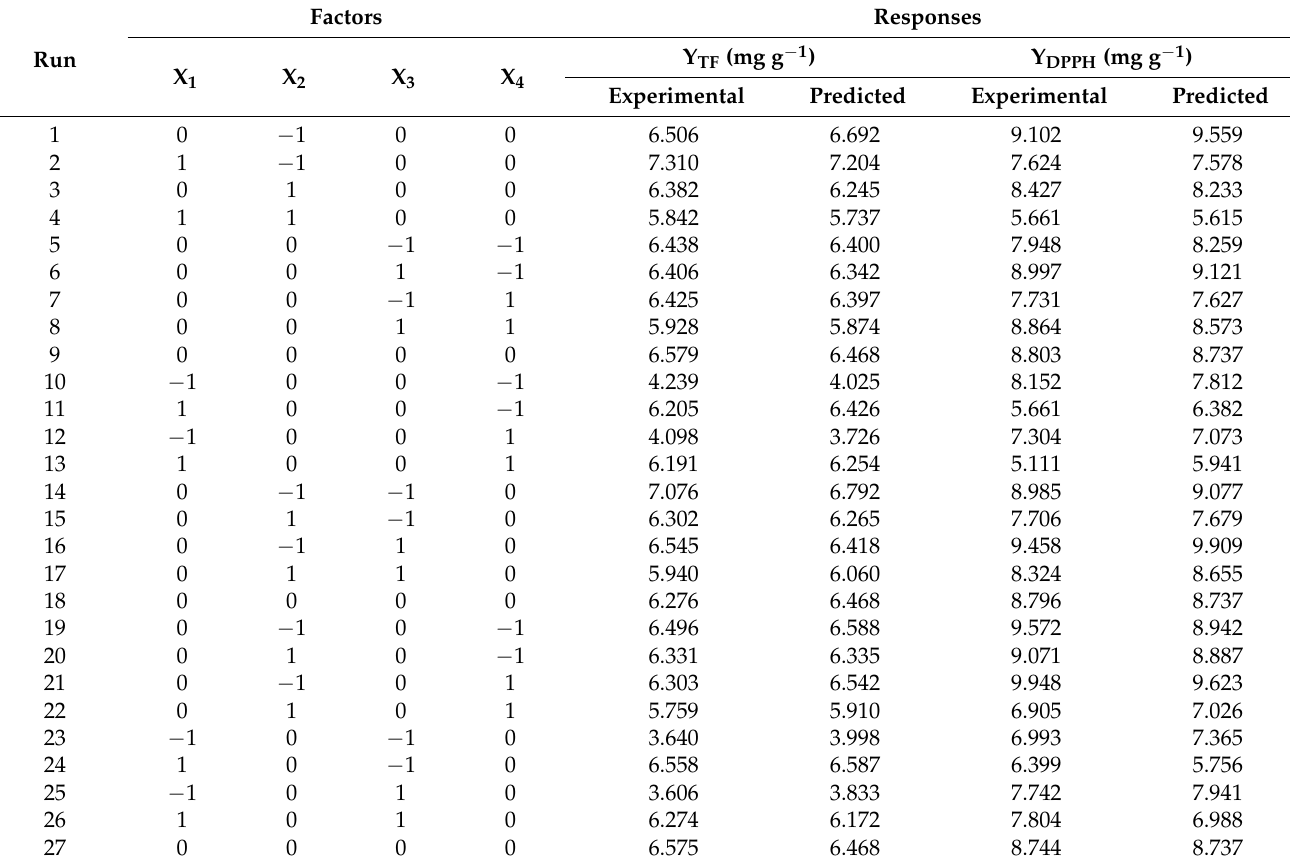
Table 2. BBD design matrix, as well as experimental and predicted values for both response variables (Y TF and Y DPPH